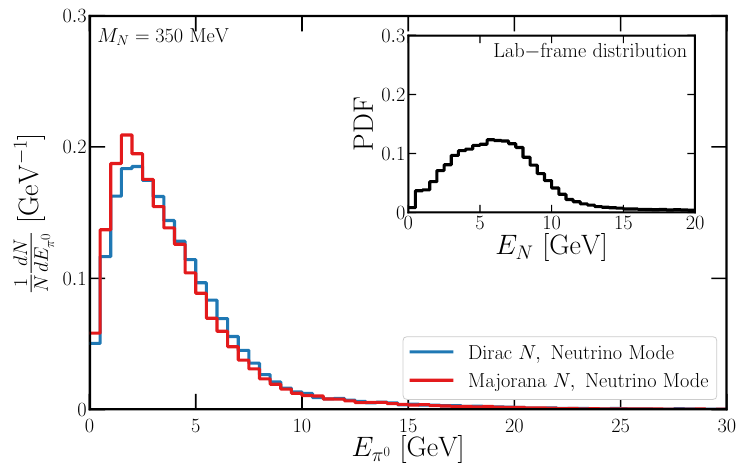
Figure 27 . Expected distribution (area normalized) of HNL decays to (cid:23)(cid:25) 0 and (cid:23)(cid:25) 0 as a function of lab-frame (cid:25) 0 energy, assuming operation in neutrino mode at the DUNE MPD. For all cases we consider M N = 350 MeV. The red line depicts this distribution for Majorana N decays, in which the N rest-frame decay is isotropic. The blue line depicts this distribution for Dirac N and N decays, in which the rest-frame decay is maximally anisotropic. The inset shows (black) the lab-frame distribution of N energies prior to their